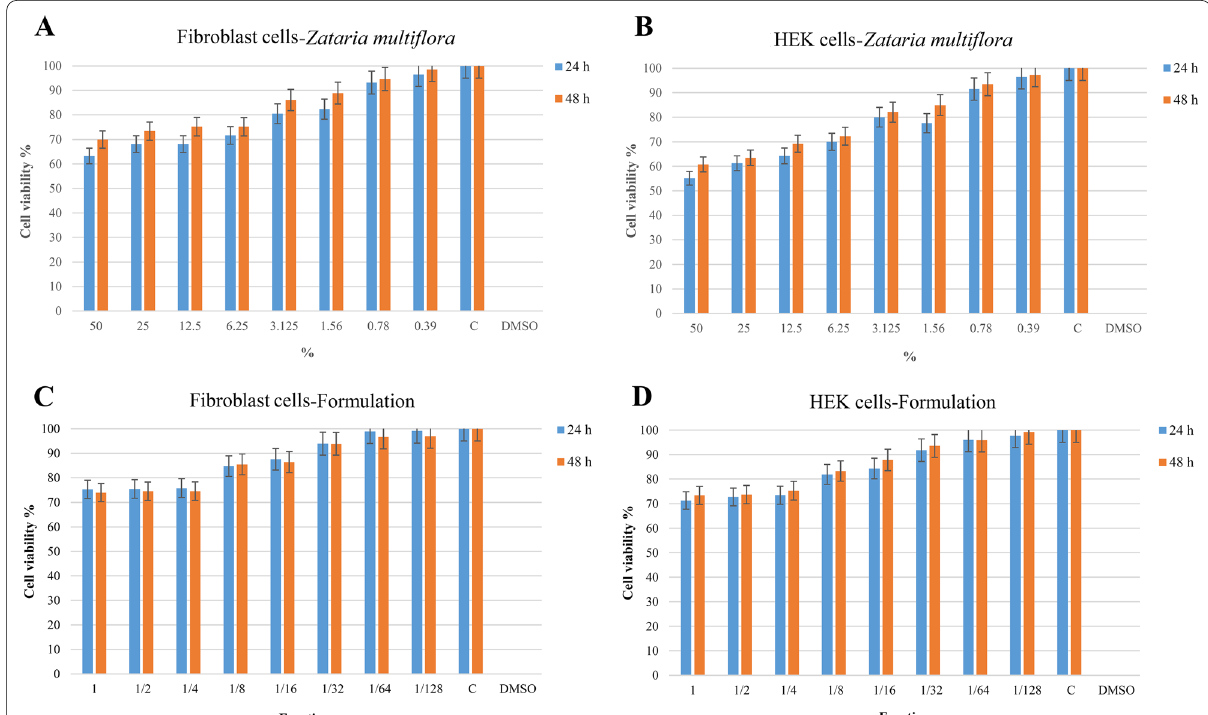
Fig. 4 Cell viability after treatment with Zataria EO and the formulation after 24 and 48 h. A The HDFa cells viability of Zataria multiflora : There are no significant differences with the control group for 0.78% mg/ml concentration and lower after 24 h ( p > 0.05). This threshold for an incubation time of 48 h would be 1.56%. B The HEK cells viability of Zataria multiflora : There are no significant differences with the control group for 0.78% mg/ ml concentration and lower after 24 h or 48 h ( p > 0.05). C The HDFa cells viability of the formulation and its serial dilutions: There was no significant difference with the control group for the volume concentration of 1/64 and lower after 24 h ( p > 0.05). This threshold for an incubation time of 48 h would be 1/32. D The HEK cells viability of the formulation and its serial dilutions: there was no significant difference with the control group for the volume concentration of 1/32 and lower after 24 or 48 h ( p >